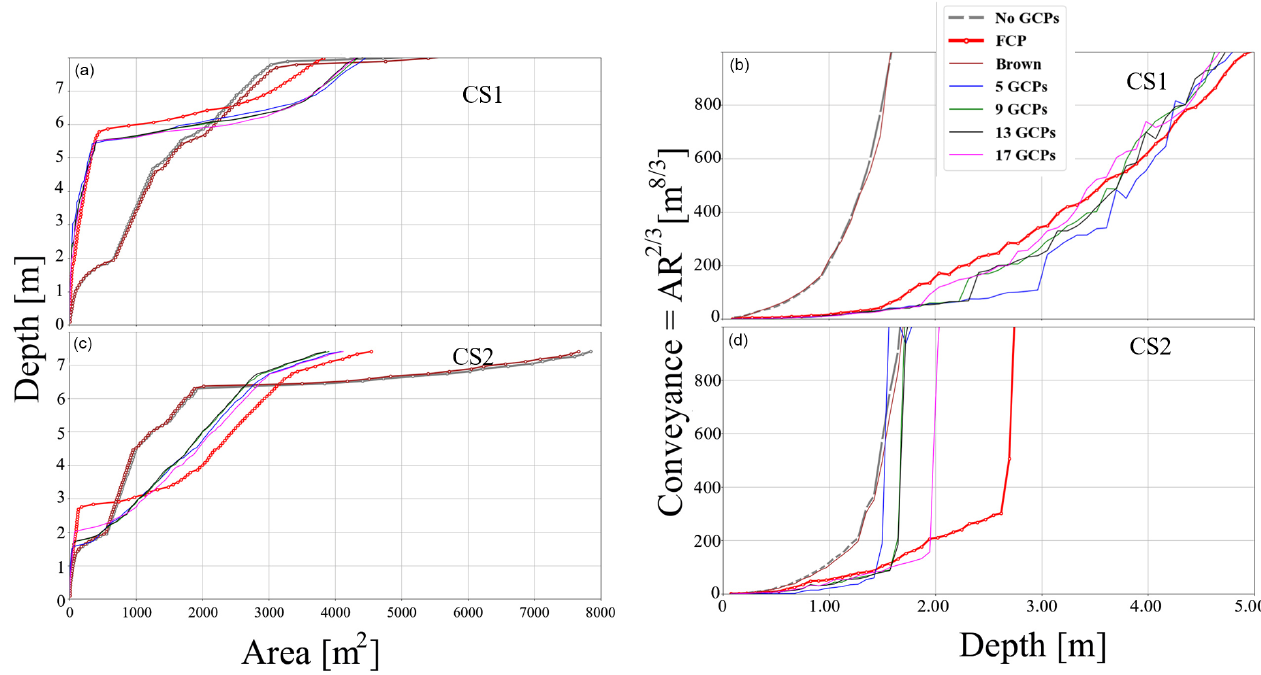
Figure B4. Depth vs. area map and conveyance vs. depth.